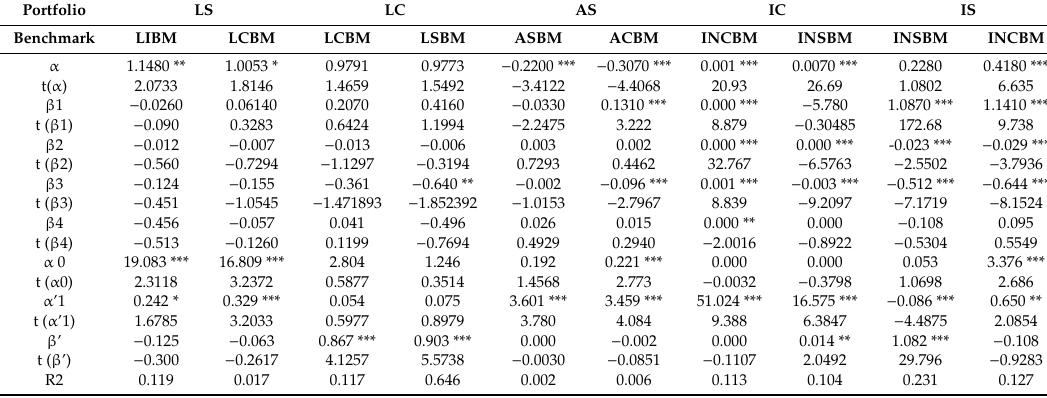
Table 5. Regression analysis on market timing and